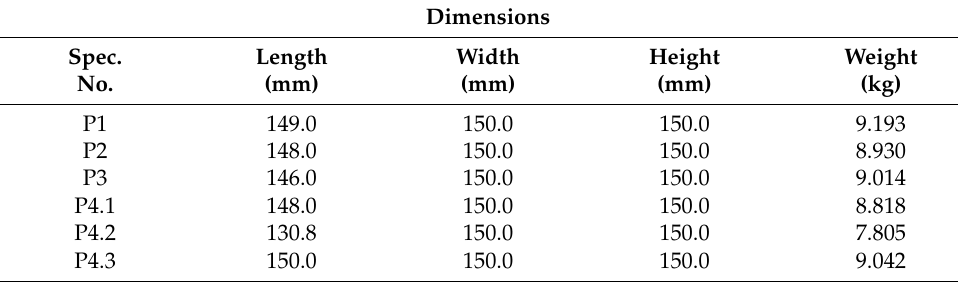
Table 1. Properties and dimensions of UHPFRC samples of batches P1–P3 and